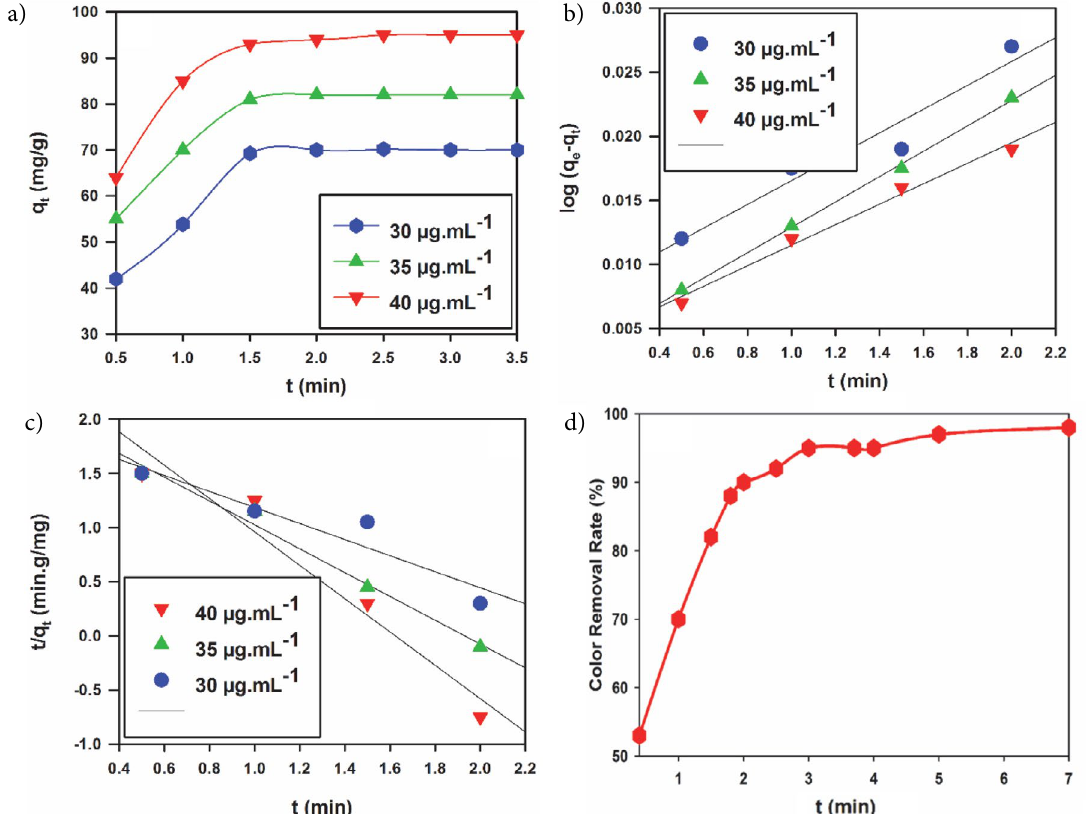
Figure 8. (a) The effect of the contact time and the concentration of Erythrosine dye solutions on the adsorption rate of the Erythrosine by the ad- sorbent, (b) The examination of the kinetic based on the pseudo-first order model and (c) The examination of the kinetic based on the pseudo-sec- ond order model (d) Average dye removal rate of Erythrosine dye from real samples obtained from chicken slaughterhouse and